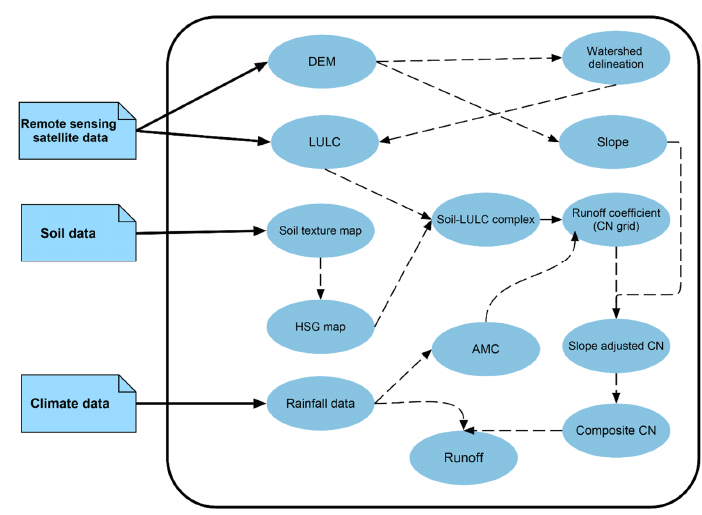
Figure 3. Flowchart showing the methodology employed by the geographic information system (GIS) based soil conservation service-curve number (SCS-CN) model in estimating the surface runoff.